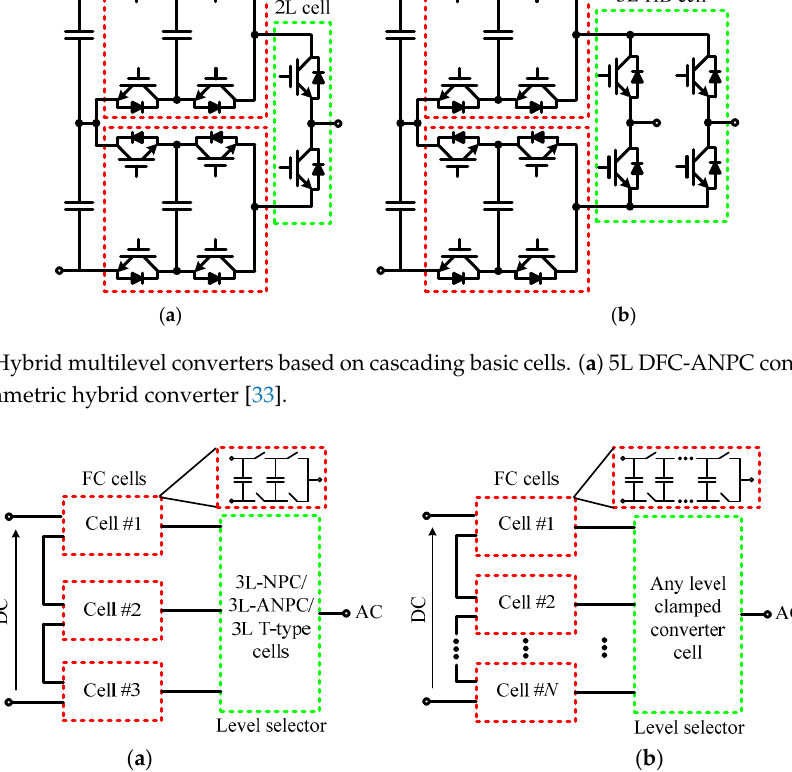
Figure 10. General topologies of hybrid cascaded multilevel converters by cascading ( a ) three 3L FC cells, ( b ) N ‐ cell multilevel FC cells.